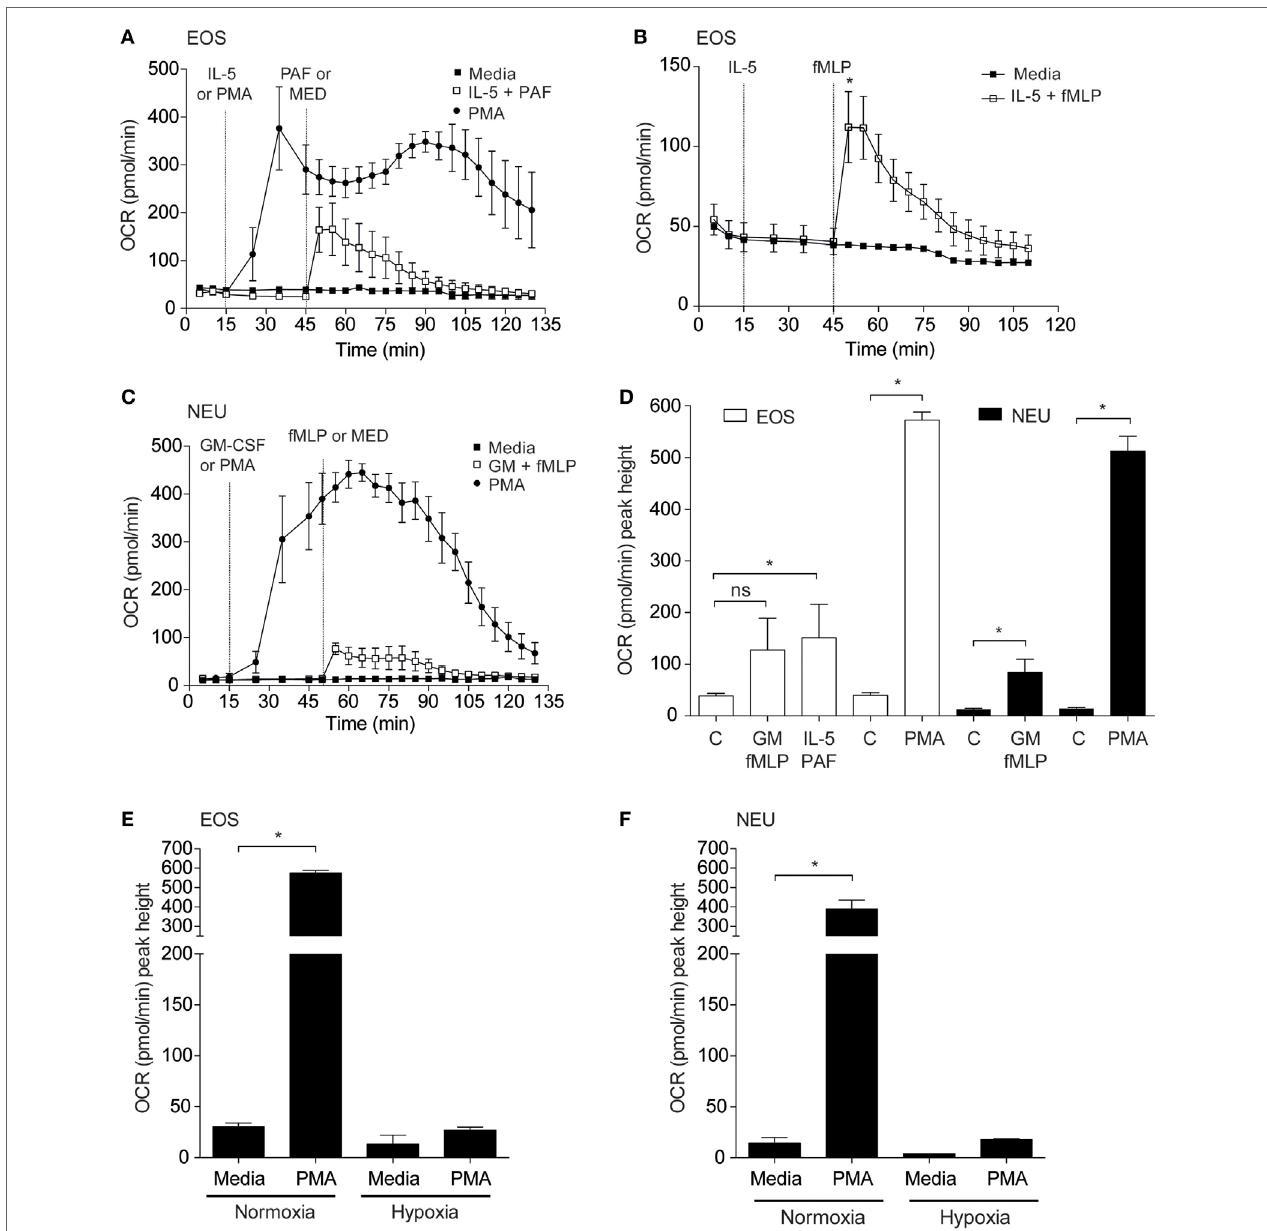
FigUre 3 | Effect of priming agents on eosinophil and neutrophil oxygen consumption rates. (a) Kinetic oxygen consumption rates (OCR) of eosinophils following injection of PMA (closed circles, 200 nM) at 15 min or PAF (open squares, 5 µM) at 45 min. Eosinophils stimulated with PAF were exposed to IL-5 (10 ng/ml) for 30 min prior to injection of PAF. Closed squares represent the media only injections. Data represent the mean ± SEM of three independent experiments. (b) Kinetic oxygen consumption rates (OCR) of eosinophils following injection of IL-5 alone at 15 min followed by fMLP injection (open squares, 100 nM) at 45 min. Closed squares represent the media only injections. Data represent the mean ± SEM of seven independent experiments (* p < 0.05 compared with media alone using a Student’s t -test). (c) Kinetic OCR responses of neutrophils following injection of PMA (closed circles, 200 nM) at 15 min or fMLP (open squares, 100 nM) at 50 min. Neutrophils stimulated with fMLP were injected with GM-CSF (10 ng/ml) for 35 min prior to fMLP treatment. Black squares represent the media only injections. Data represent the mean ± SEM of three independent experiments. (D) Comparison of the peak height OCR by eosinophils (white bars) and peak height OCR by neutrophils (black bars). Treatments were performed as described in (a,c) . Data represent the mean ± SEM of four independent experiments for GM-CSF/fMLP stimulation, five independent experiments for PAF/fMLP, and ≥ 4 independent experiments for PMA (* p < 0.05 compared with media alone using a Student’s t -test). Ns indicates a non-significant difference. (e) Comparison of eosinophil peak height OCR following PMA (200 nM) injection under normoxia or hypoxia. Data represent the mean ± SEM of ≥ 4 independent experiments under normoxia (* p < 0.05 compared with media alone using a Student’s t -test) and mean ± SD of two independent experiments under hypoxia. (F) Comparison of neutrophil peak height OCR following PMA (200 nM) injection under normoxia or hypoxia. Data represent the mean ± SEM of ≥ 4 independent experiments under normoxia (* p < 0.05 compared with media alone using a Student’s t -test) and mean ± SD of two independent experiments under hypoxia. Eosinophil and neutrophil OCR responses were measured simultaneously on the same assay plate (D,e)